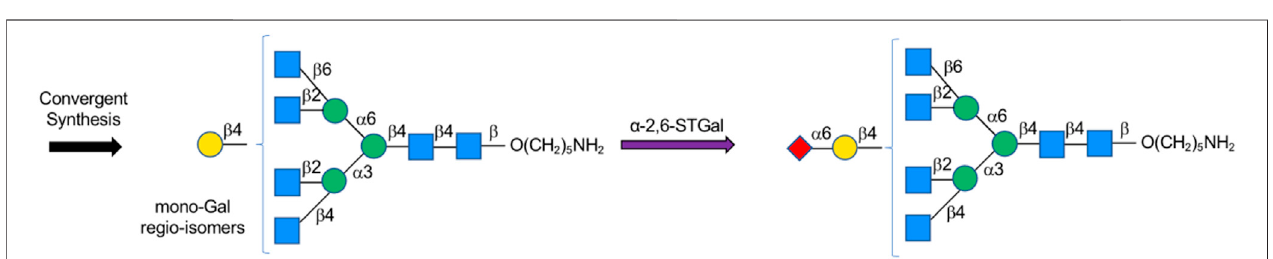
FIGURE 11 | Asymmetric glycan common-substrate